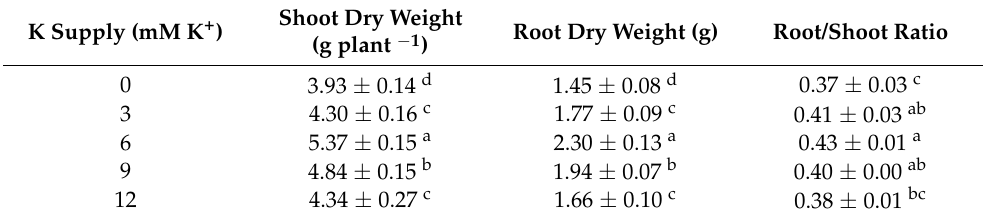
Table 1. Developmental effects of different K supply on M9T337 [19]. Different letters denote significantly different values. Shoot Dry Weight K Supply (mM K + ) Root Dry Weight (g) Root/Shoot Ratio (g plant − 1 ) 0